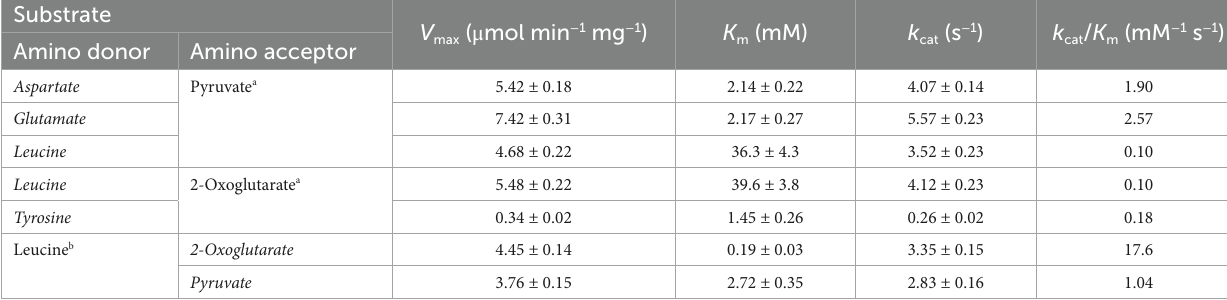
TABLE 2 Kinetic parameters of the aminotransferase reaction catalyzed by the TK2268 protein. Substrate